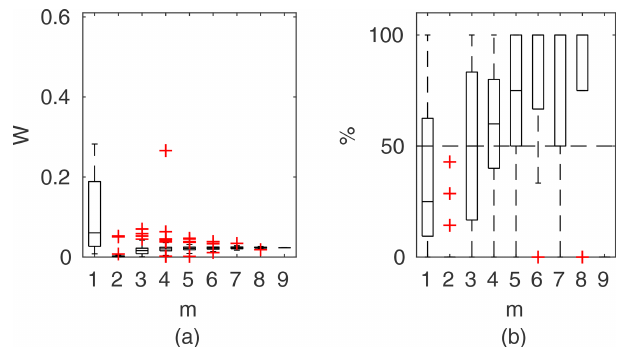
Figure B3. Mertens results for flume case 1: (a) averaged relative confidence widths W as a function of observation set size m used for model identification; (b) percentage of verification points en- closed by the confidence intervals (100% denotes all points within intervals, box spans over the 25% and 75% quantiles, the median is given with horizontal line, whiskers indicate the result extent, and cross marks are for extreme values).